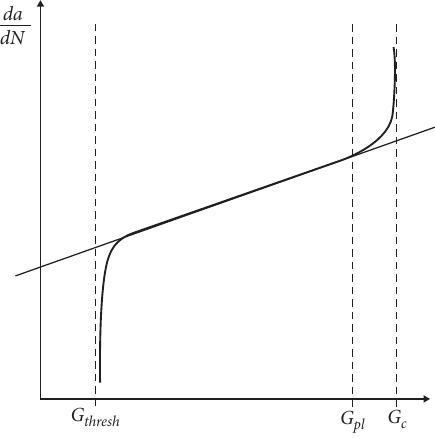
Figure 4: Fatigue crack propagation